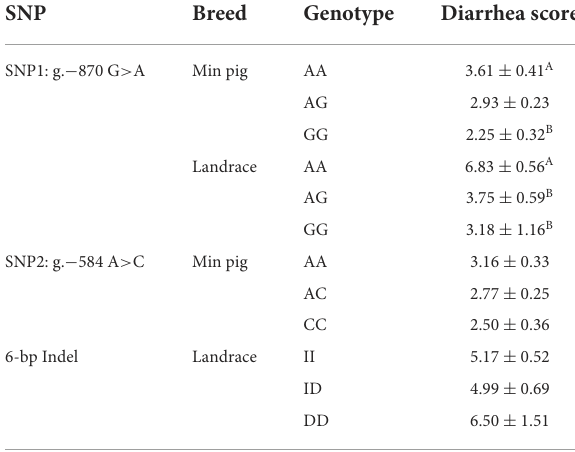
TABLE 5 Association between functional genetic variations in STAT3 gene and piglet diarrhea score in Min pig and Landrace